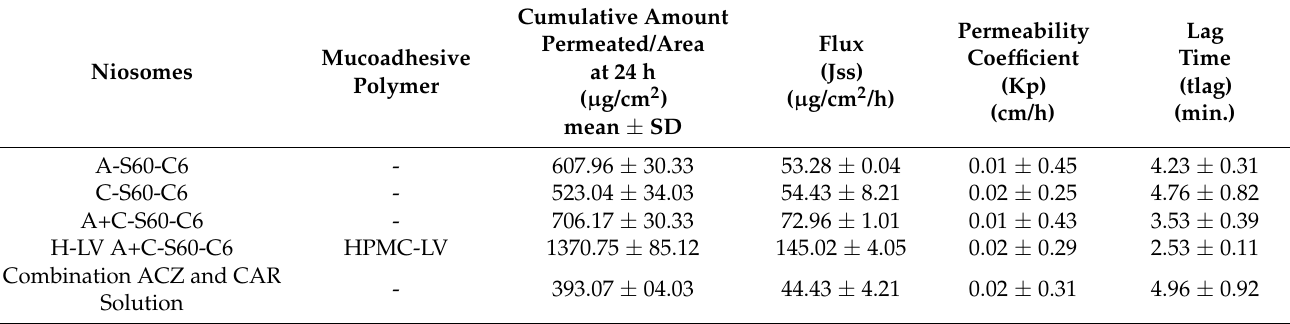
Figure 4. Mean IOP of hypertensive rabbits for first 48 h with a different administration in comparison with physiological minimum IOP for rabbit (IOP lower limit) and physiological maximum (IOP upper limit). Table 4. Permeation parameters of in vitro release profiles of ACZ and CAR loaded niosomes formulations through membrane compare to their solution.